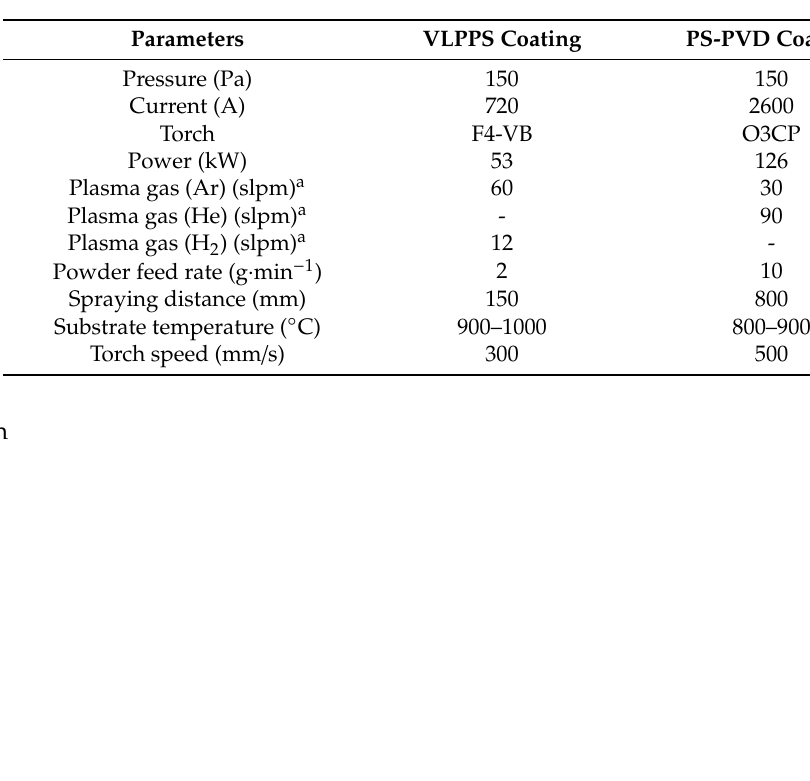
Table 2. Parameters of the very-low-pressure plasma spray (VLPPS) and plasma spray–physical vapor deposition